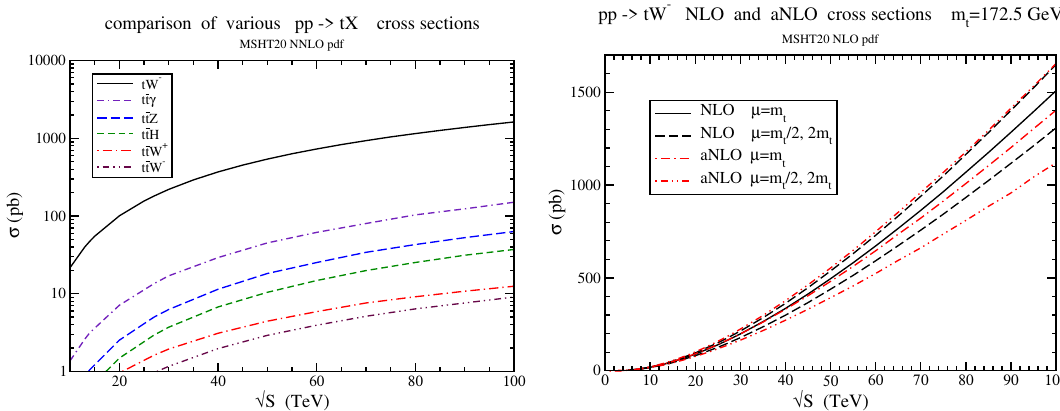
Figure 1: (left plot) A comparison of various tX cross sections; (right plot) NLO and aNLO cross sections for tW